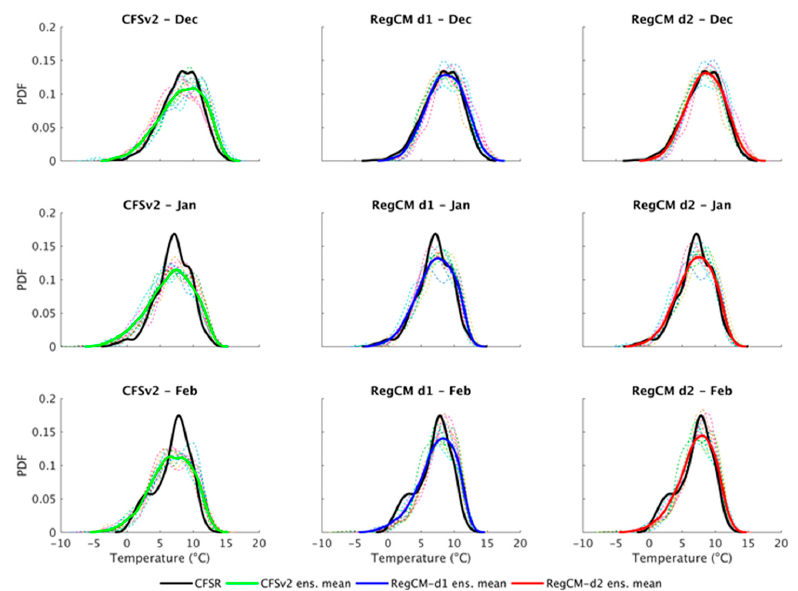
Figure 3. Climatological temperature statistical distribution, shown as probability density functions (PDFs) of the three seasonal forecast systems ensemble means (tick solid lines). Green, blue, and red lines represent the CFSv2, RegCM-d1, and RegCM-d2, respectively. Multi-colored thin lines refer to the individual ensemble member PDFs for three forecast systems. Black tick solid lines represent the reanalysis PDF. Climate 2019 , 7 , 120